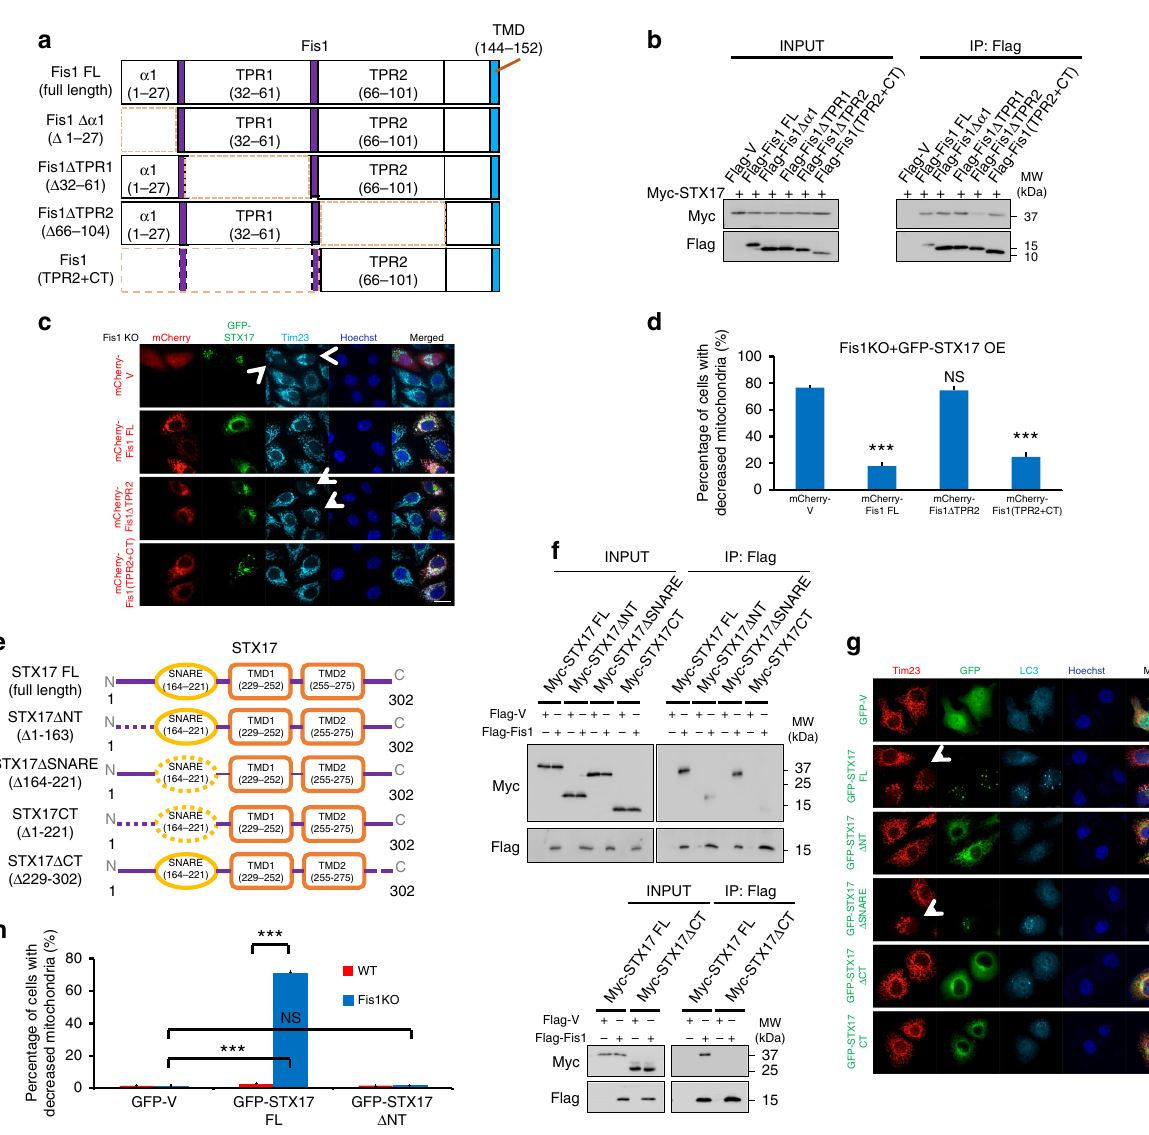
Fig. 4 The functional domains of mitochondrial fi ssion 1 protein (Fis1) and syntaxin 17 (STX17) for mitophagy. a Schematic diagram of Fis1 truncations. The deleted regions are represented by dotted lines. b HEK293T Cells were transiently co-transfected with the indicated plasmids for 24 h. Cells were lysed and immunoprecipitated with anti-Flag antibody. Co-immunoprecipitated Myc-tagged STX17 was detected by immunoblotting. c Fis1 KO HeLa cells were co- transfected with green fl uorescent protein (GFP)-tagged STX17 (green) and plasmids encoding mCherry-Fis1 truncations (red). Cells were fi xed, stained with Tim23 antibody (cyan), and then imaged for fl uorescence microscopy. Hoechst, blue. Scale bar, 10 µ m. Arrowheads indicate mitophagic cells. d Quanti fi cation of c . *** P < 0.001, NS, not signi fi cant (two-tailed unpaired Student ’ s t test, n = 150 cells from three independent experiments). e Schematic representation of STX17 domain mutants. Dotted regions represent deleted domains. f HEK293T cells were co-transfected with the indicated plasmids. After 24 h, cells were extracted and co-immunoprecipitated with anti-Flag beads, followed by immunoblotting with anti-Myc and anti-Flag antibodies, respectively. g Fis1 KO cells were transfected with GFP-tagged vector or the indicated STX17 truncations for 24 h. Cells were imaged following immunostaining for Tim23 (red) and LC3 (cyan). Hoechst, blue. Scale bar, 10 µ m. Arrowheads indicate mitophagic cells. h Quantitative analysis of mitophagy induced by STX17 full-length (FL) or truncations in Fis1 KO cells. *** P < 0.001, NS, not signi fi cant (two-tailed unpaired Student ’ s t test, n = 150 cells from three independent experiments). Data are mean ± SD ( d , h